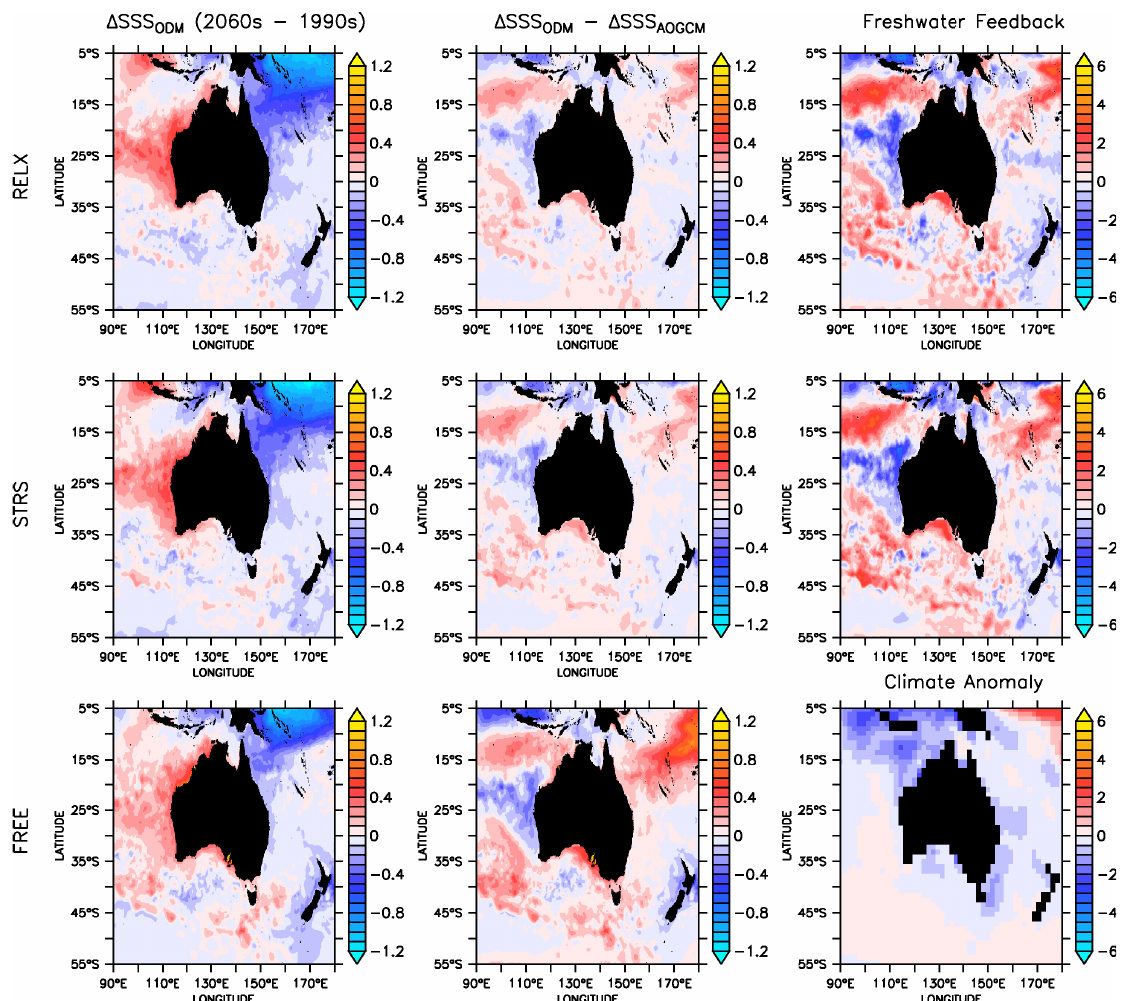
Fig. 11. Annual averages of: projected climate change in SSS from the ODM (left column, in psu), differences in climate change for SSS (centre, psu), and freshwater flux feedback (right, mmday − 1 ). For comparison, the average climate change freshwater flux anomaly is shown in the bottom right panel. The RELX experiment is shown along the top, STRS is in the middle, and FREE is at the